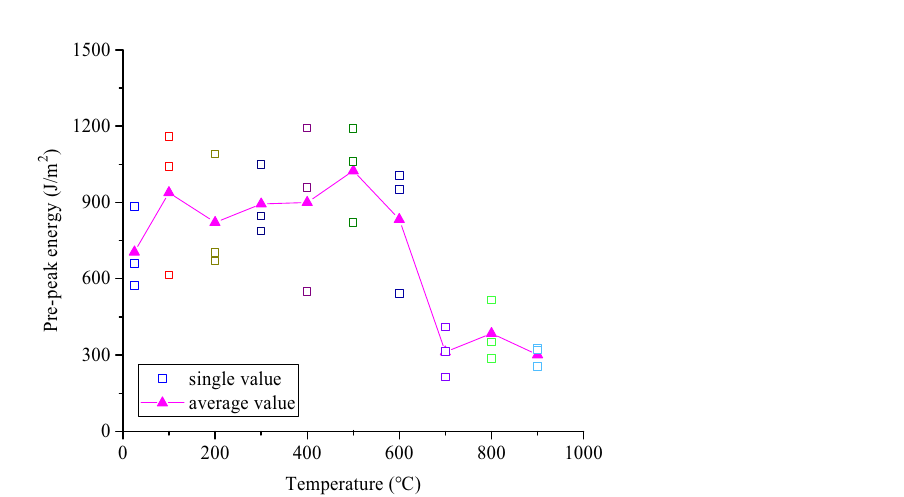
where σ t is the tensile strength (MPa), V p is the longitudinal wave velocity (m/s), x and y are constants. The coarse sandstone samples was damaged after heat treatment, which reduces the longitudinal wave velocity and changes their tensile strength. The relationship between the tensile strength of the coarse sandstone samples and their longitudinal wave velocity is shown in Fig. 13. The tensile strength of the coarse sandstone samples treated at different temperatures and their longitudinal wave velocity satisfies a quadratic function fitting relationship, as shown in Eq. (9):